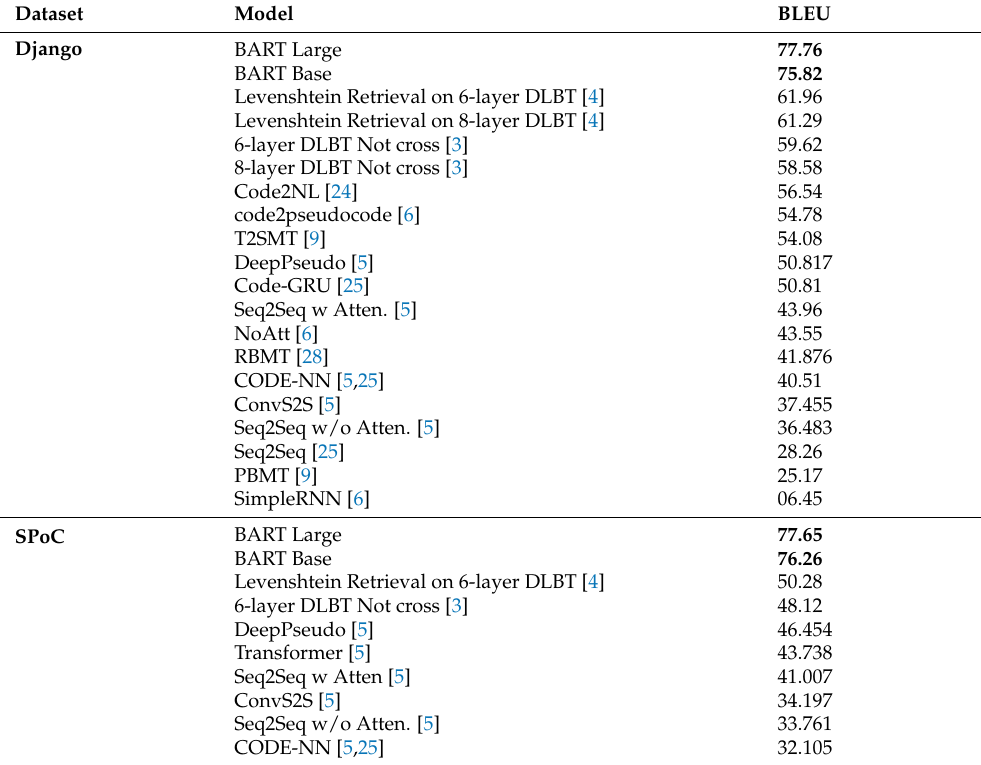
Table 7. The comparison between the proposed model and state-of-the-art models on Django and SPoC datasets.